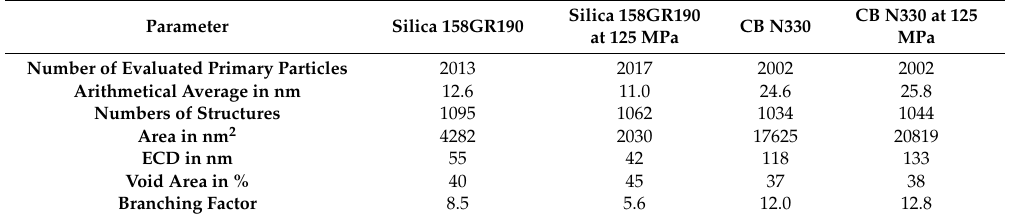
Table 5. Evaluation of average primary particles and cluster sizes, void area and branching factor